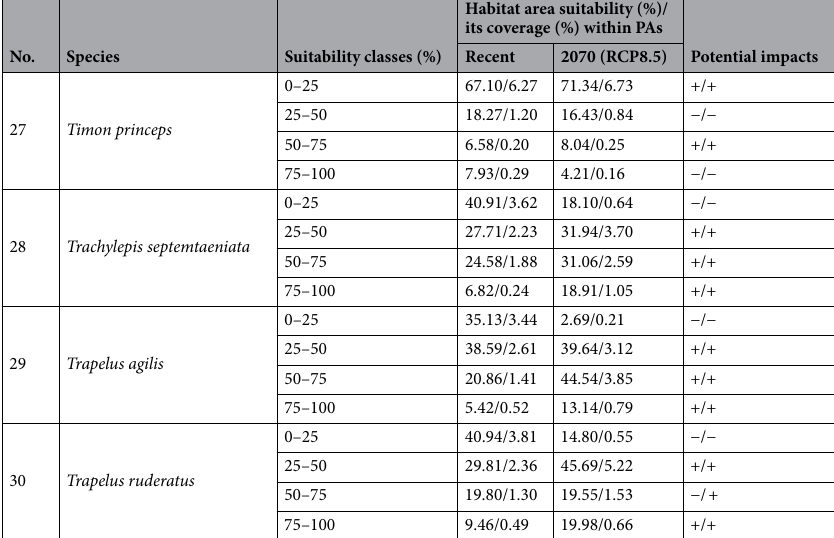
(Fig. 3 PP1 and PP2). Based on the consensus model under RCP2.6 and RCP8.5, habitat loss was estimated at 10.91% and 37.32%, and new habitat gain at 87.11% and 90.96%, respectively (Table 3).